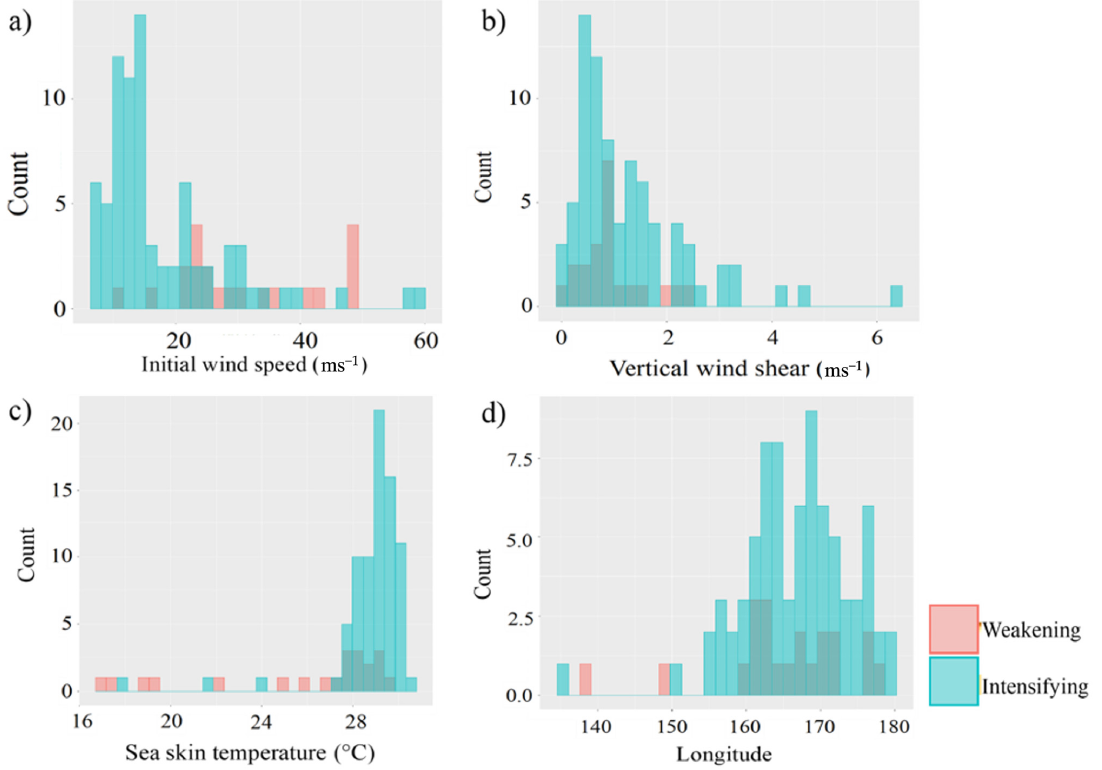
Figure 10. Histograms that show the frequency distribution of a ) initial intensity, b ) VWS, c ) SkT, and d ) longitude for the intensifying and weakening cases of the SWPO island landfall TCs. The four most important variables identified by the LOOCV ROSE sampling RF model were selected to showcase their difference during the intensifying and weakening events.